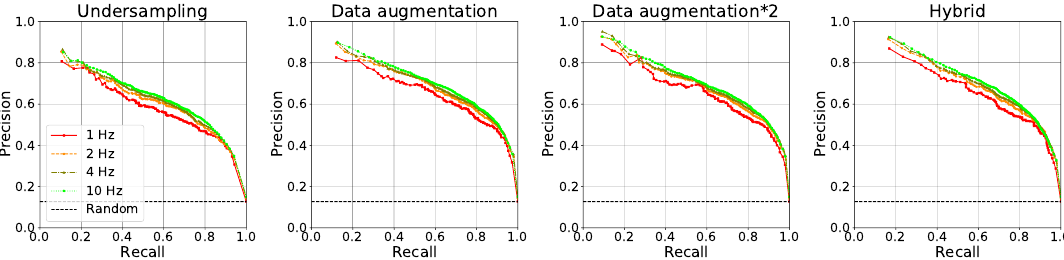
Figure 6. YAMNet Precision–Recall curves comparing each inference frequency for different datasets.